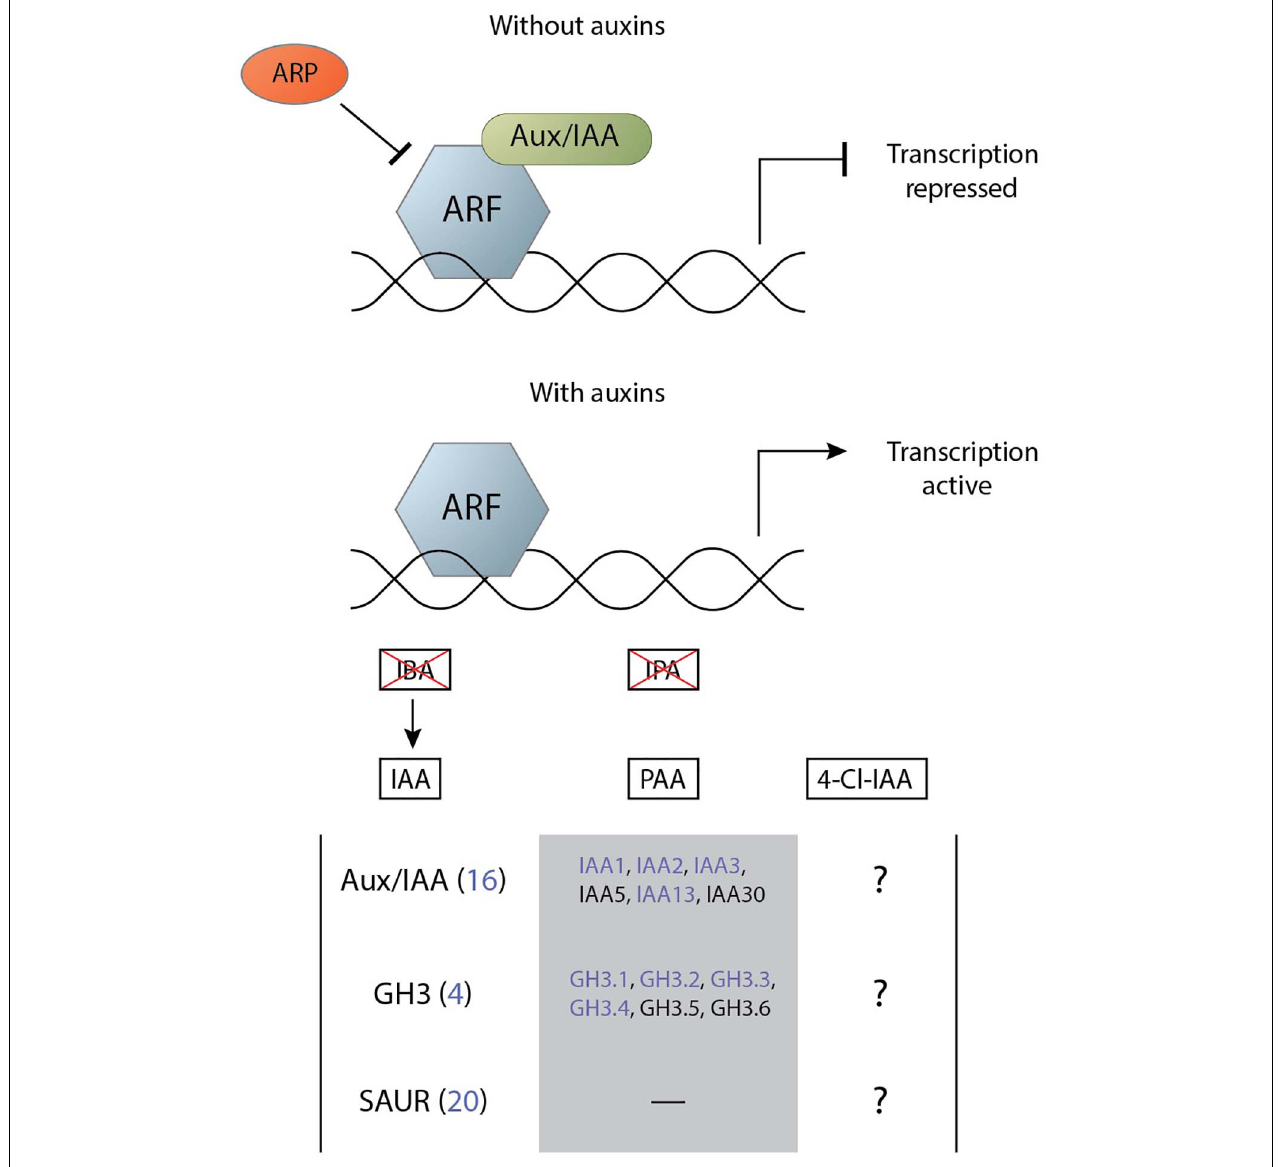
FIGURE 4 | Simplified mechanism of auxin perception through the TIR1-AFB signalling cascade leading to the activation of primary auxin response genes. Transcription of auxin response genes is repressed by the Aux/IAA and ARP proteins (top). The presence of the auxins PAA, IAA, and 4-Cl-IAA degrade Aux/IAA and allow for gene transcription by ARF (bottom). The effect of the auxin IBA on transcription by ARF is mediated via conversion into IAA and the auxin IPA does not significantly activate the signalling pathway. Members of three primary response gene families can be activated by this system, of which various members are differentially regulated in feeding sites of cyst and root-knot nematodes (indicated in purple) ( Supplementary Table 1 ). There is partial overlap between the genes that can be activated by PAA and those that are activated by IAA. On the other hand, it is unknown which primary response genes 4-Cl-IAA can